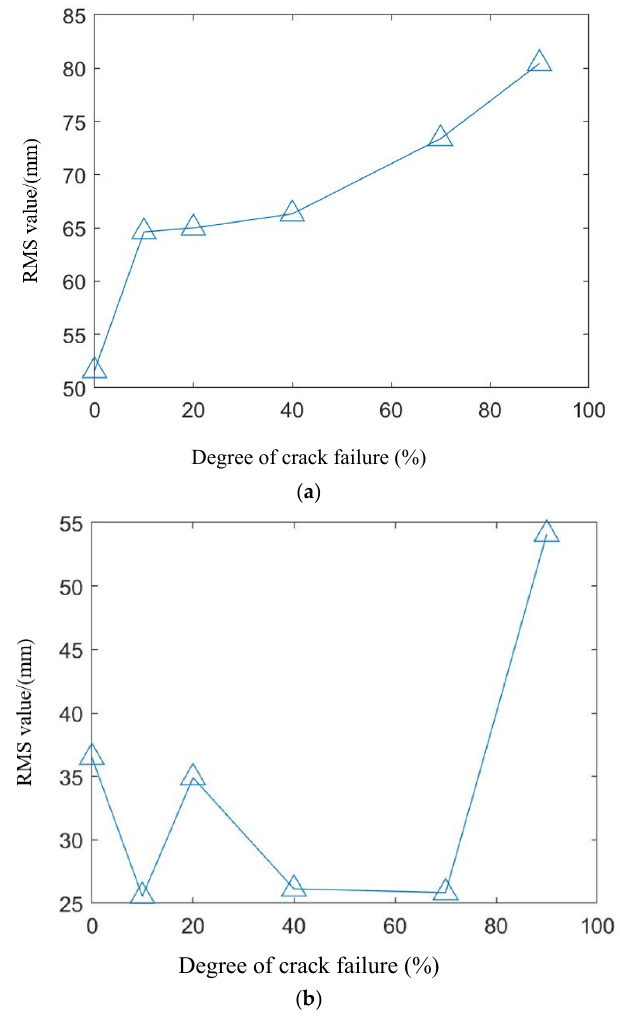
Figure 15. Comparison of the two models: ( a ) Root-mean-square value of the digital twin model; ( b ) Root-mean-square value of the traditional model.